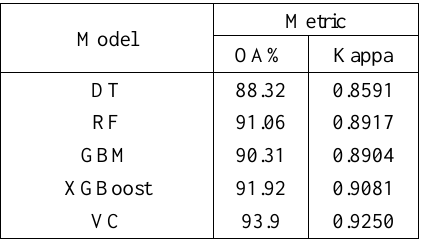
Table 3 . Accuracy assessment of the classification